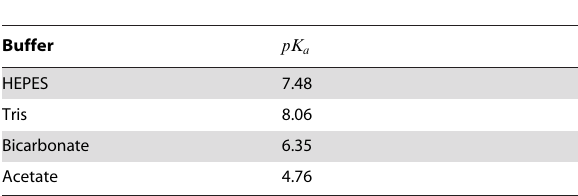
Table 2. Dissociation constants of pH buffers.